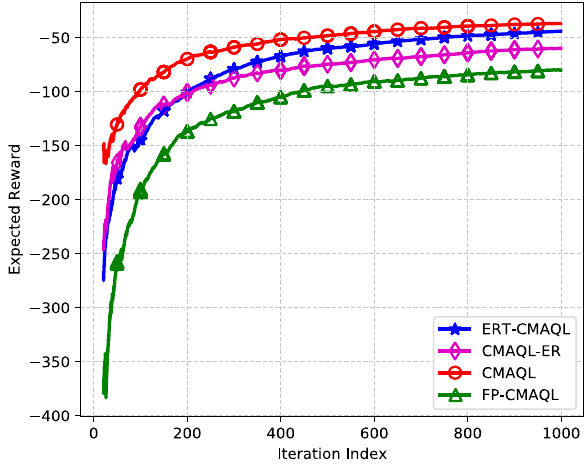
Figure 3. Expected reward of the SU 6 versus the iteration index.